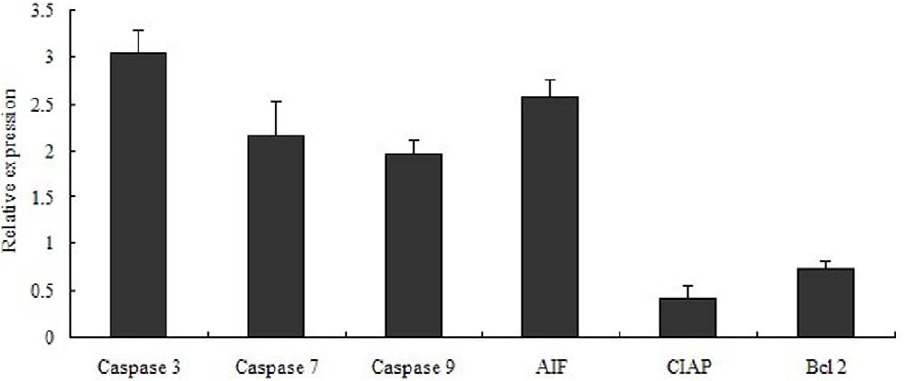
Figure 5. Relative expression of six genes in schistosomula from Microtusfortis compared with those from BALB/c mice by using qPCR. The data show the mean and standard error derived from triplicate